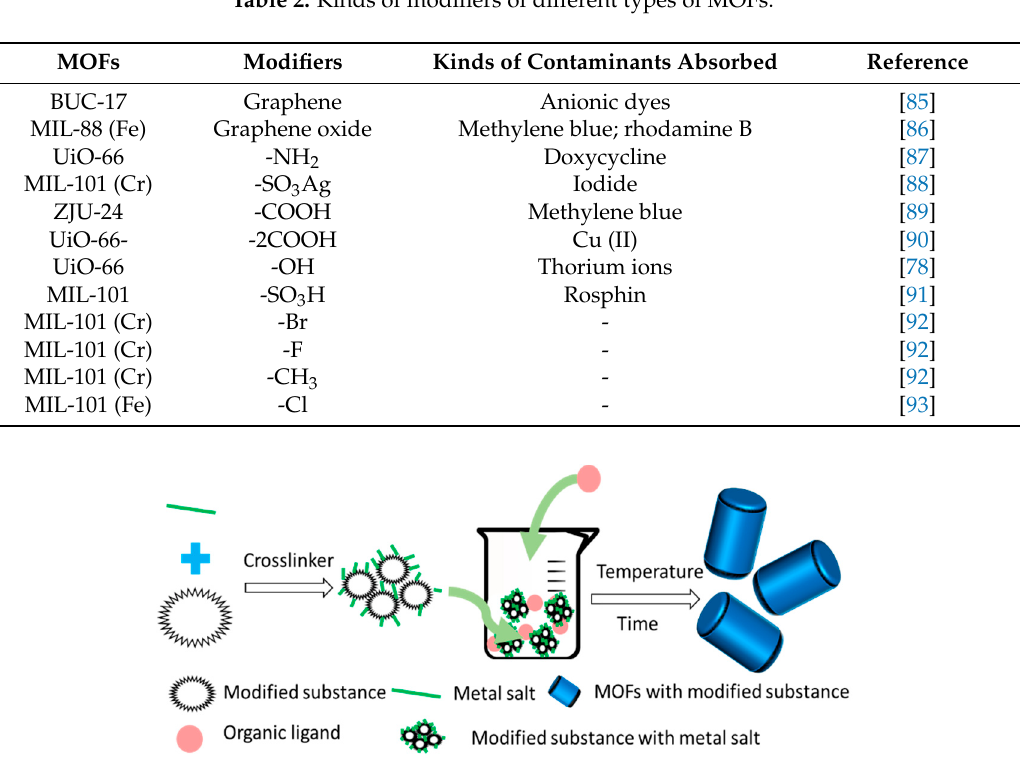
Table 2. Kinds of modifiers of different types of MOFs.